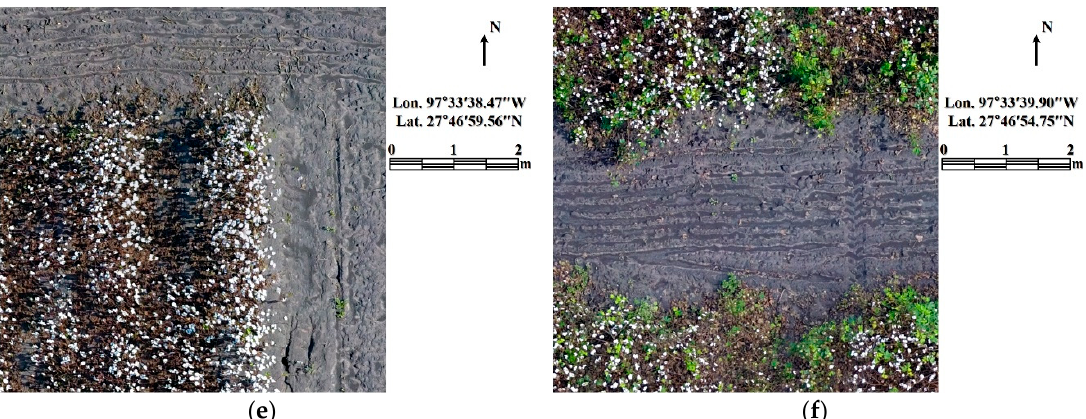
Figure 4. UAV images. ( a ) orthomosaic image of the rainfed area (north) and accuracy test area (N3); ( b ) orthomosaic image of the irrigated area (south) and accuracy test area (S3); ( c , e ) subset images of the rainfed area (N1 and N2); ( d , f ) subset images of the irrigated area (S1 and S2).